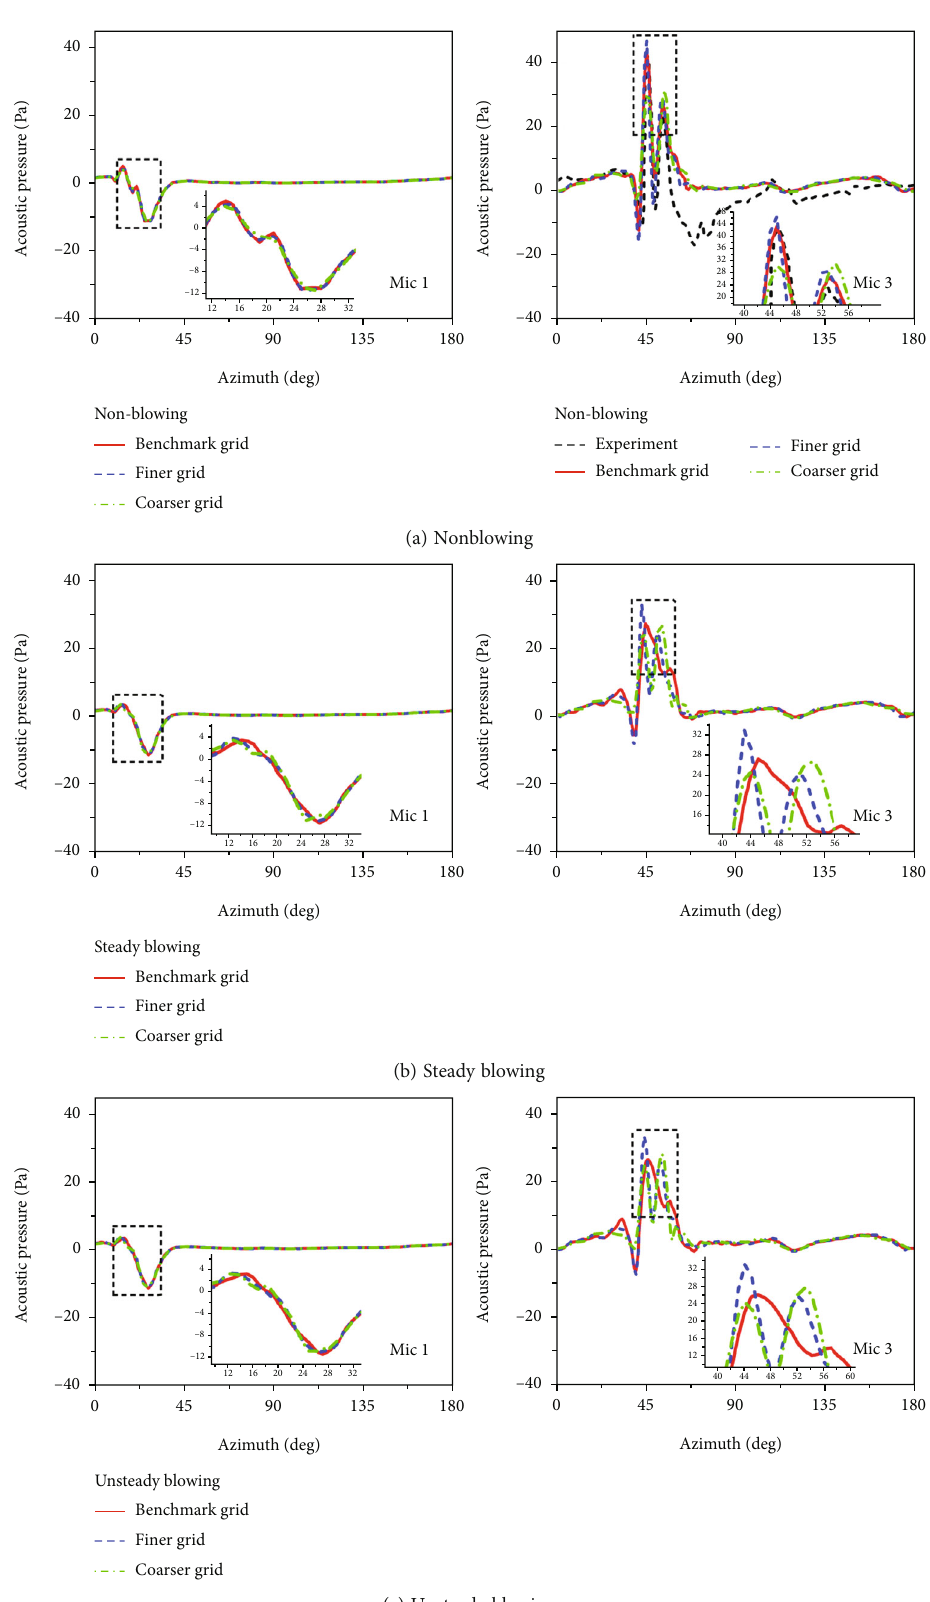
Figure 8: Acoustic pressure time history at microphones 1 and 3 for the steady/unsteady blowing cases under the three background grid